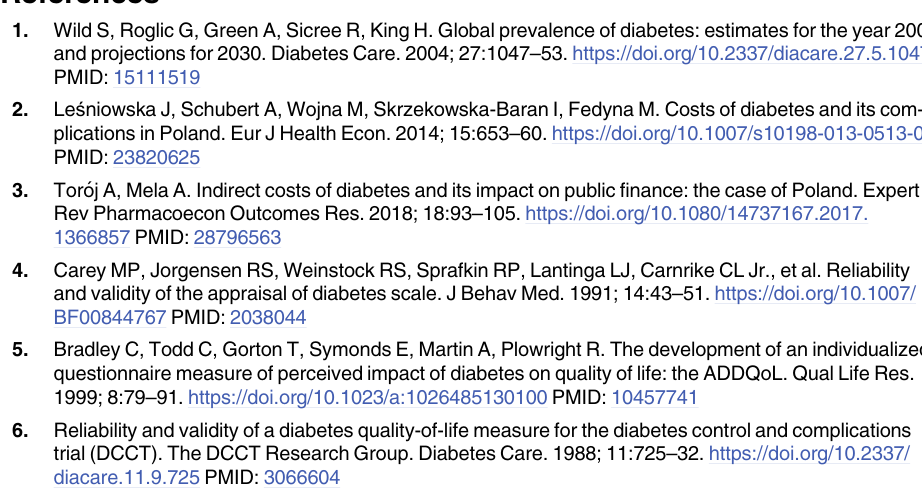
S1 Fig. Mean EQ VAS in respondents with self-reported diabetes according to voivodeship. S2 Fig. Mean EQ-5D-5L index in respondents with self-reported diabetes according to voi- vodeship. S3 Fig. Cumulative percentage of limitations within EQ-5D-5L dimensions in patients with diabetes compared to respondents without diabetes, according to age